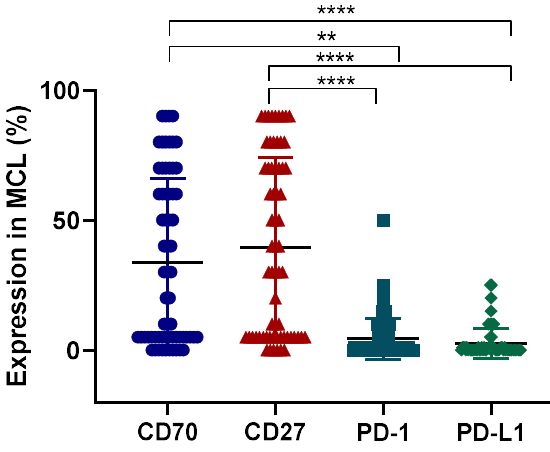
Figure 8. Expression levels of CD70, CD27, PD-1, and PD-L1 in MCL cohort. The expression of CD70 CD27, PD-1, and PD-L1 in a total of 65 MCL samples. Y axis shows percentage of positive cells for a particular protein. Each symbol represents a di ff erent patient. ** p < 0.01, **** p < 0.0001.